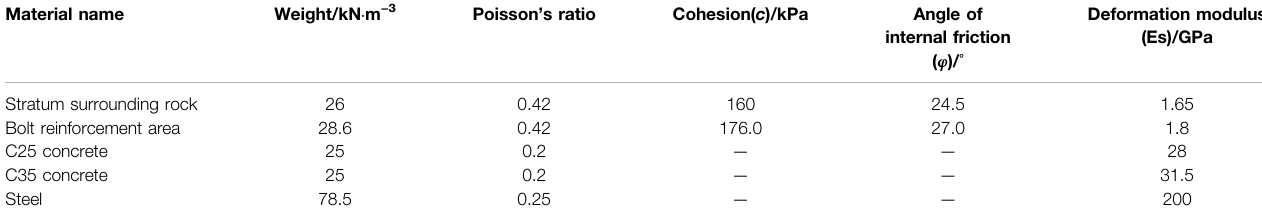
TABLE 2 | Physical and mechanical parameters of model materials.